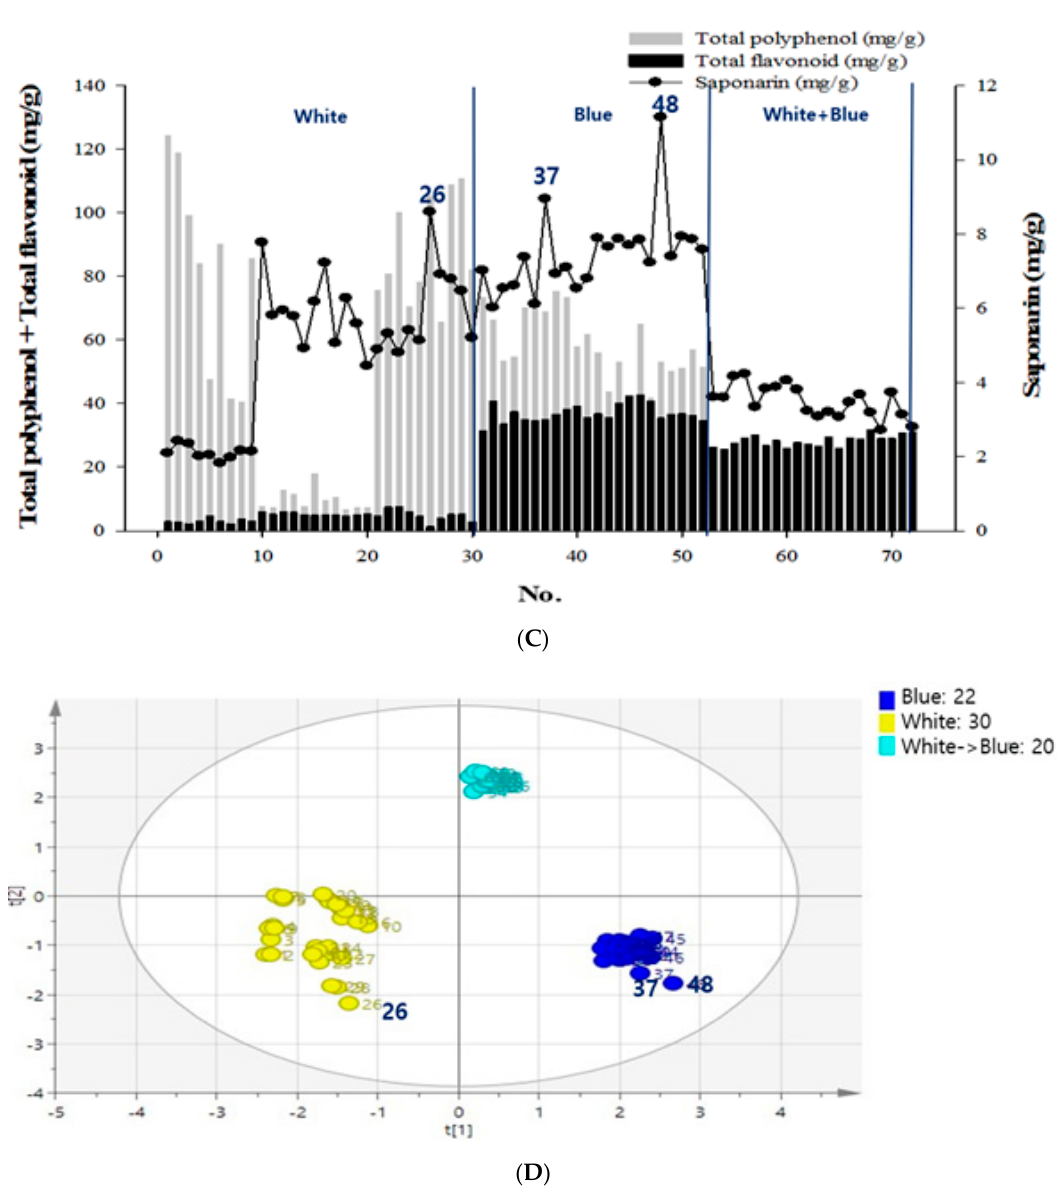
Figure 1. Contents of chemical compounds—flavonoid, polyphenol, and saponarin and principal component analysis (PCA) of the secondary metabolites in barley sprouts (BS). ( A ) Total flavonoid and polyphenol contents of the 238 samples cultivated in red, white, or blue light. ( B ) Total polyphenol and flavonoid contents of the 238 samples grown under different LED light sources. ( C ) The conditions of 72 samples selected were analyzed for total flavonoid, total polyphenol, and saponarin. ( D ) The total polyphenol, flavonoid, and saponarin contents for the 72 samples were selected from the nutrient supplementation groups with boric acid and zinc under white light or blue light. Test sample was one and data were expressed as the mean of three independent experiment, and then PCA analysis was performed with the mean value.